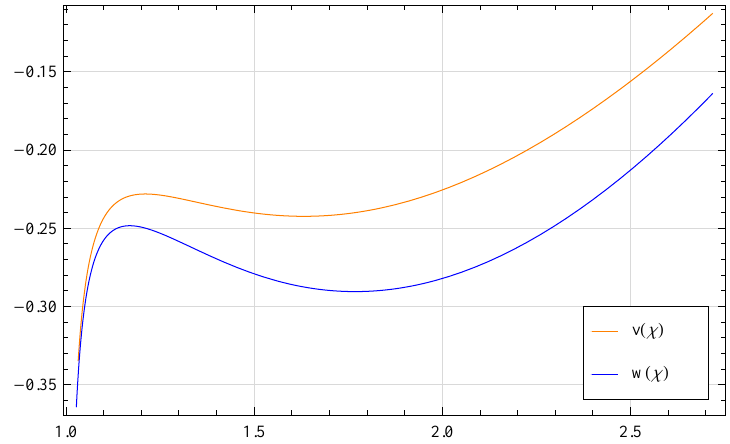
Figure 1. Sketch of solution in case (i) .